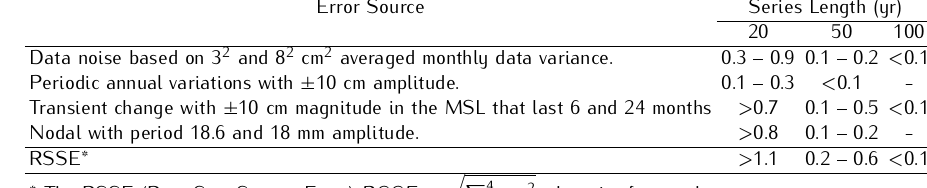
Table 7. Contribution of the unmodeled effects to the trend estimate (mm/yr). Error Source Series Length (yr) 20 Data noise based on 3 2 and 8 2 cm 2 averaged monthly data